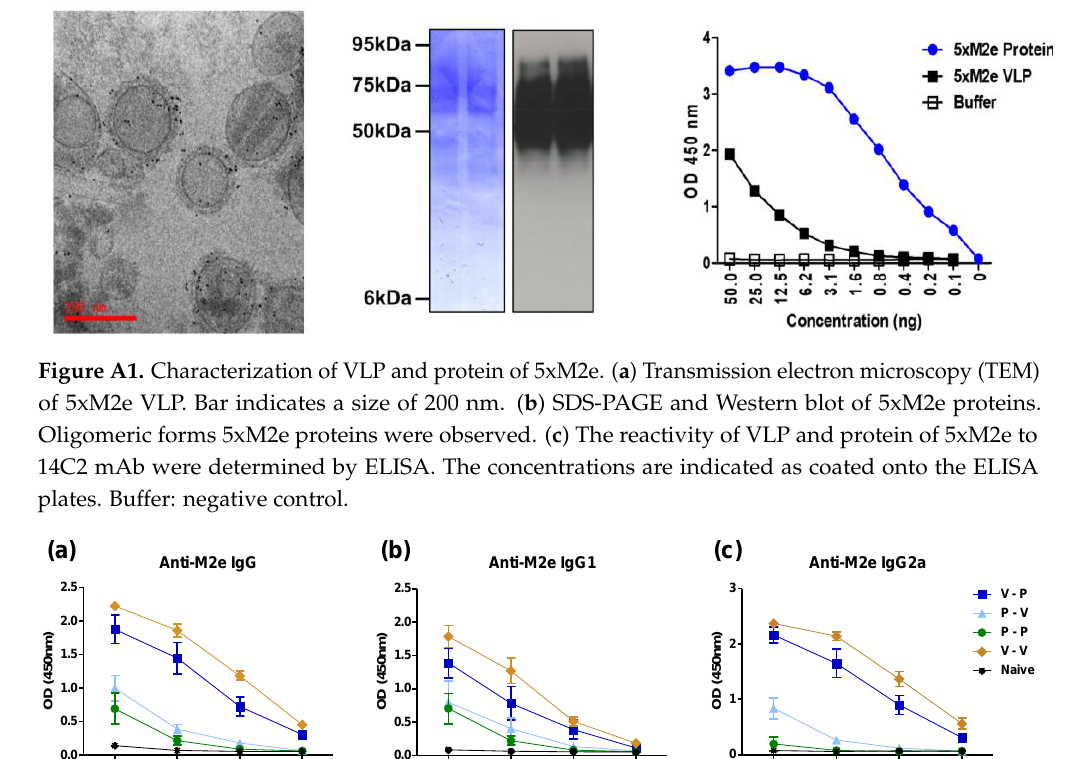
Supplementary Figure 3. Protective effects by M1 VLP immunization. M1 VLP immunized mice (n=8 per group) were infected with a lethal dose of A/Philippines/2/1982 (H3N2) at 6 weeks after boost immunization. (a) Body weight changes. (b) Lung viral titers were detected by inoculating chicken eggs. EID 50 , 50% egg infections dose. (c) The spot numbers of IFN-γ in the lungs. Lung cells collected at 6 dpi were stimulated with 4 µg/ml inactivated H3N2 (iH3N2) virus for 48 h. IFN-γ secreting cells were determined by ELISpot. The statistical significance was confirmedby one-way ANOVA and Dunnett’s multiple comparison test. Error bars indicate the means ± SEMof pooledsamples fromeachgroupofanimals.***; p <0.001.